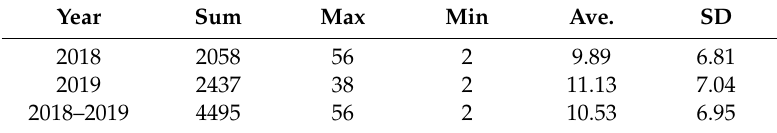
Figure 4. Air compressor spare parts. Table 2. Statistical description of historical sale data added up to days (2018-2019). Table 1. Historical sale data of Piston rings added up to 24 months (2018–2019).